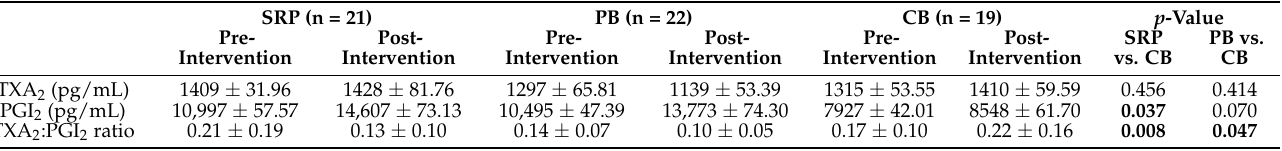
Table 3. Urinary eicosanoid levels in healthy adults from the ARISTOTLE study before and after the